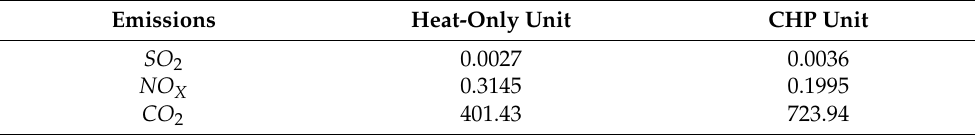
Table 2. Emission factors related to SO 2 , NO X , and CO 2 .